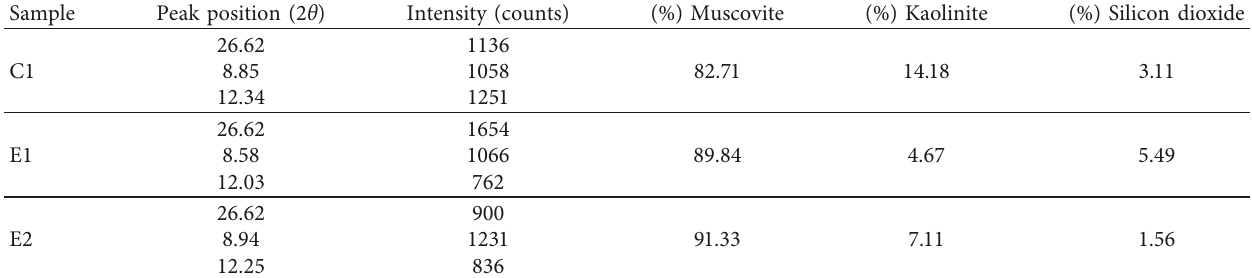
Table 1: Peak position and percent composition of the clay samples.